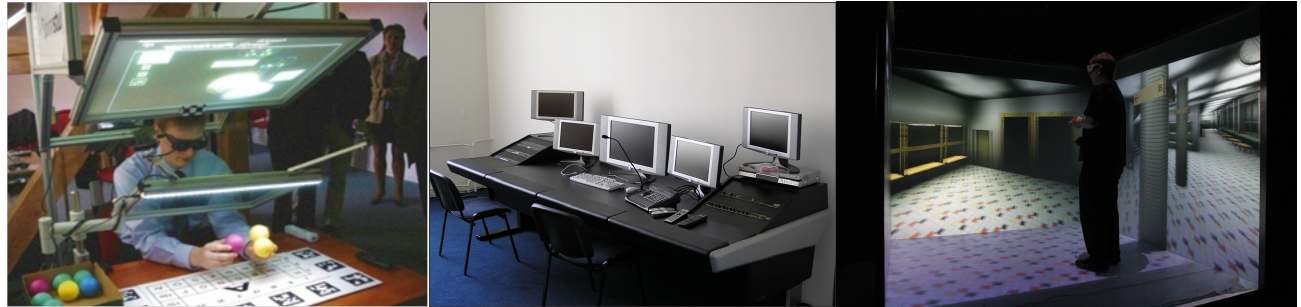
Fig. 1. Overview of the DCGI labs: (left) Augmented reality setup at the Virtual Reality Lab, (center) the Usability Lab, (right) CAVE at the Institute of